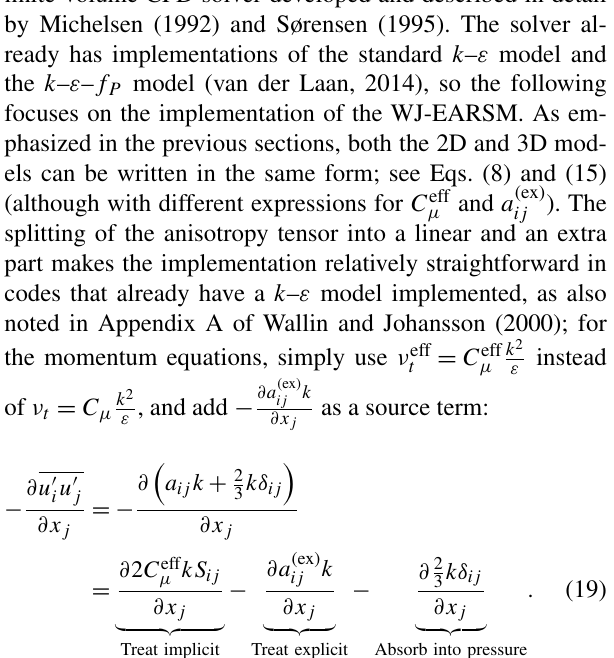
Table 2. Model constants for the WJ-EARSM as recommended by Želi et al. (2020). Referred to later as “Zeli coefs”. C ε 1 C ε 2 σ k σ ε κ c 1 c 2 1.44 1.82 1.00 1.30 0.38 1.8 5